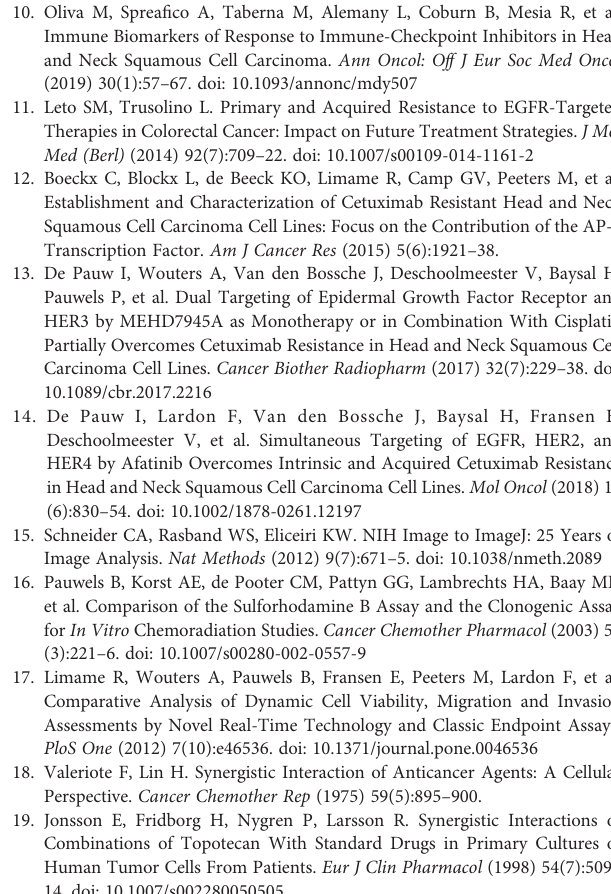
Supplementary Figure 3 | The cytotoxic effect of cetuximab for 168h with MK2206 added during the last 72h of treatment. (A) IC 50 of MK2206 for cetuximab sensitive HNSCC cell lines after combination treatment. (B) IC 50 of MK2206 for acquired cetuximab sensitive HNSCC cell lines after combination treatment. (C) Combination index (CI) versus fraction affected (FA) plot of 1 m M MK2206 with fi xed doses of cetuximab (0.5 nM, 1 nM and 5 nM)in SC263-S (red) and SCC22b-S (blue). (D) Combination index (CI) versus fraction affected (FA) plot of 1 m M MK2206 with fi xed doses of cetuximab (5 nM, 25 nM and 50 nM) in SC263-R (green) and SCC22b-R (orange). *, signi fi cant difference in IC 50 compared to MK2206 monotherapy (p < 0.050). CI < 0.800, CI = 1.000 ± 0.200 and CI > 1.200 indicated synergism, additive effect, and antagonism, respectively. Suf fi x -S: cetuximab sensitive cell line and suf fi x -R: acquired cetuximab resistant cell